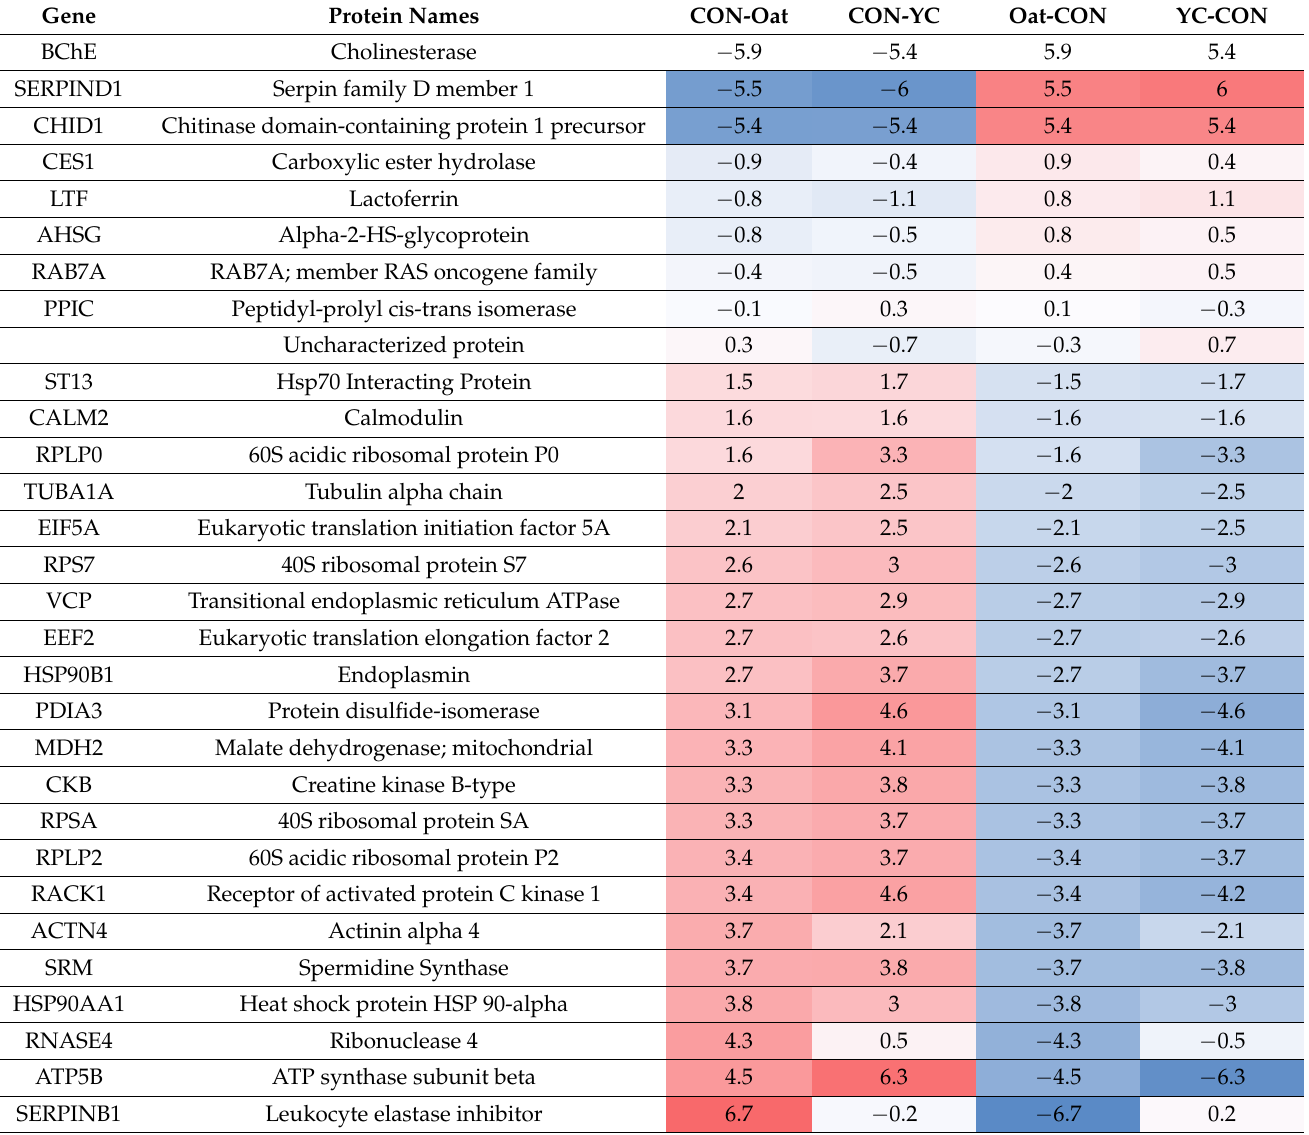
Table 6. Quantitative proteomic analysis. Milk proteins differentially abundant between samples of sows fed CON, Oat or YC diets. Results are expressed as fold change of the difference in protein expression between the two treatments appearing in the heading. Cell color were assigned to label upregulated (red) and downregulated (blue) proteins between treatments.